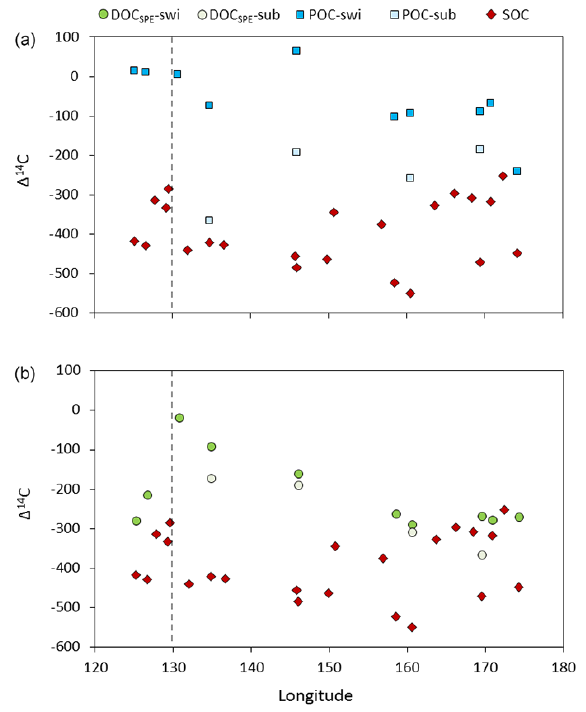
Figure 5. Longitudinal distribution of (cid:49) 14 C signatures in DOC SPE (green circles), POC (blue squares) and SOC (red diamonds); swi: seawater intake samples (surface water samples at 8m depth); sub: samples obtained by submersible pump (near-bottom water sam- ples, 5m above bottom). Dashed lines indicate the latitude of the Lena River mouth.